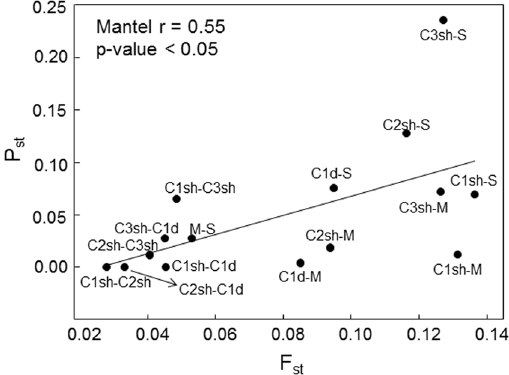
Figure 5. Pairwise P ST vs. pairwise F ST . Relation between P ST and F ST . Results of a Mantel test with the corresponding p-value and the regression line are shown. M: Medes; C1sh, C2sh and C3sh: Calanques 1, 2 and 3 shallow respectively; C1d: Calanques 1 deep; S: